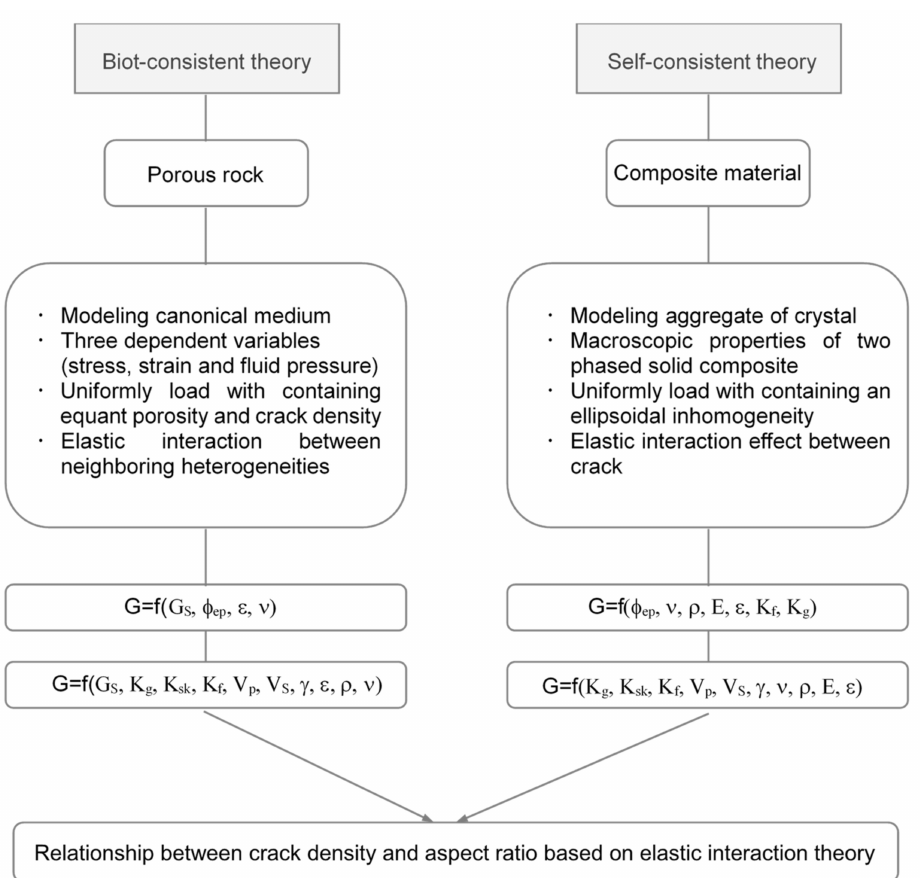
Figure 1. Relationship between Biot-consistent and self-consistent theories. G s is the shear modulus of a grain; K g , K sk , and K f are the mean bulk moduli of a grain, skeleton, and fluid; V P and V S are compressional and shear wave velocities, respectively; γ , ν , and E are mass density, Poisson’s ratio, and Young’s modulus, respectively; and ρ and ε are aspect ratio and crack density,